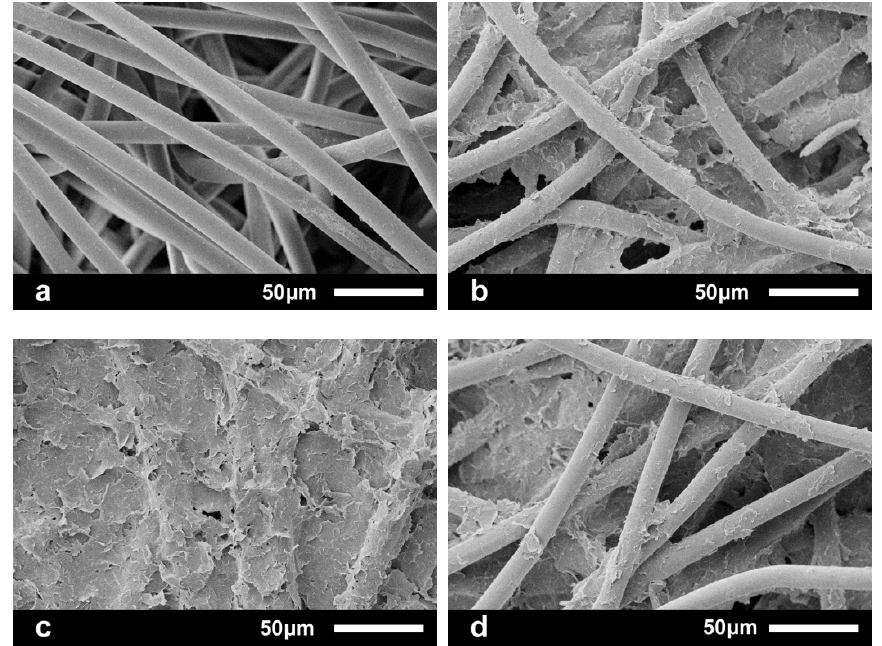
Figure 2. SEM images of nonwoven and composites from various coating processes. ( a ) No coating, ( b ) 1-layer coating, ( c ) 2-layer coating, and ( d ) 2-sided coating.